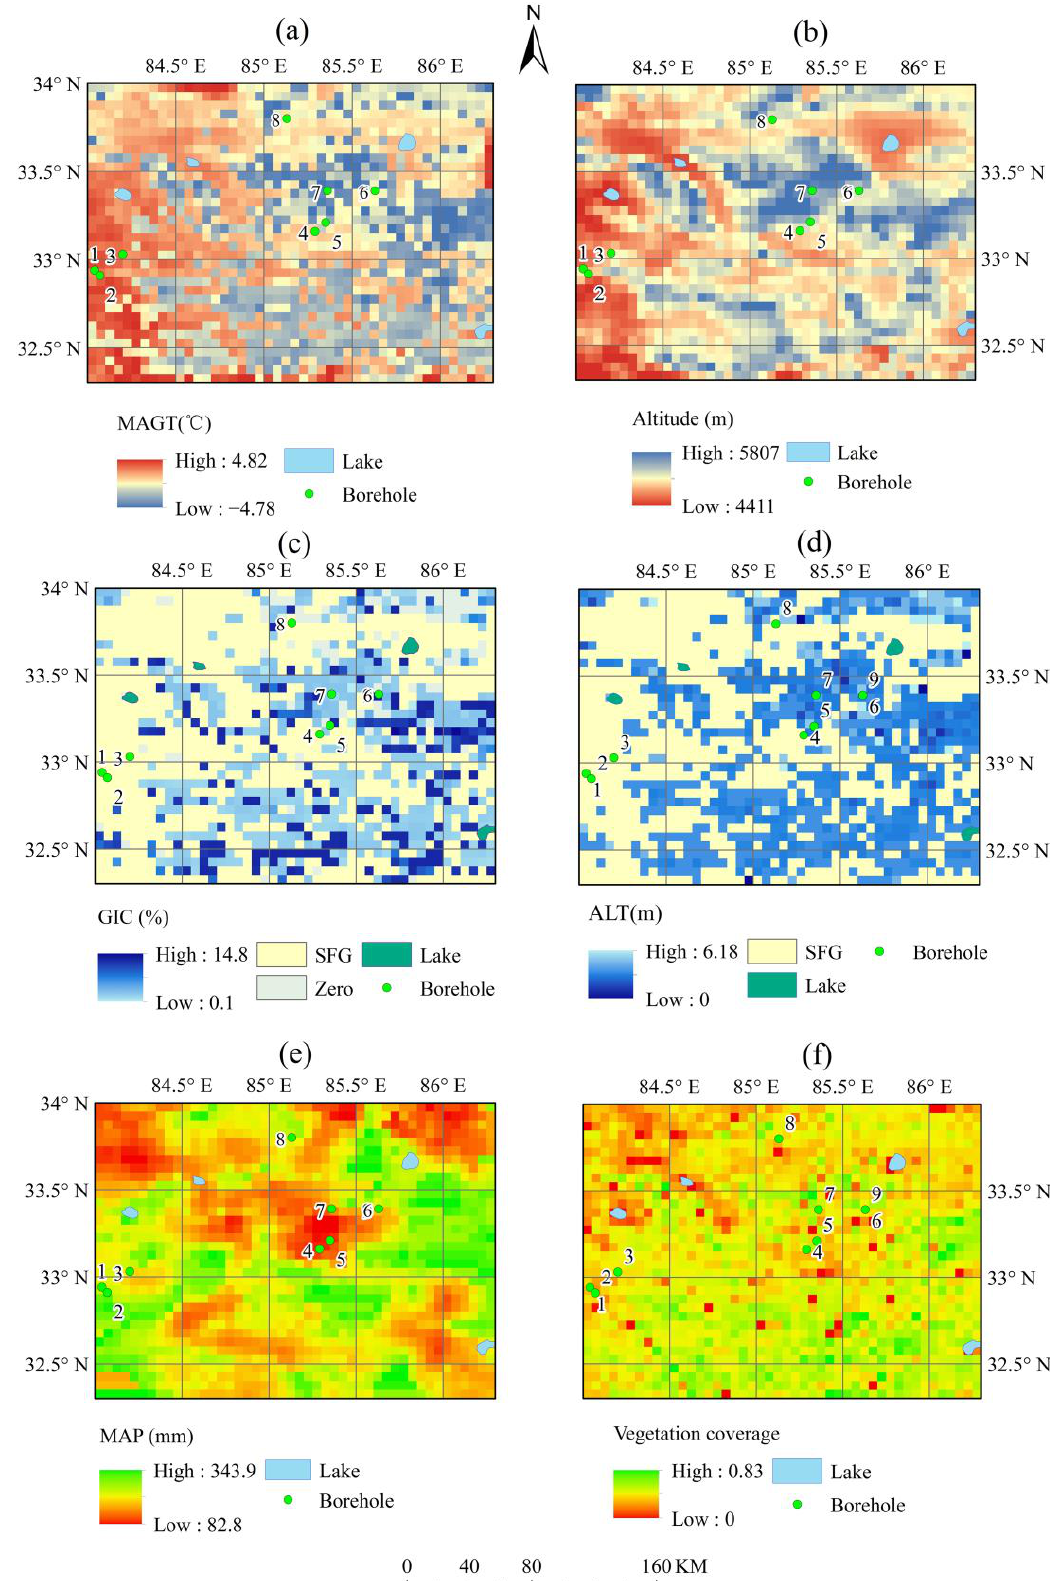
Figure 8. Distribution of ( a ) simulated MAGT; ( b ) altitude; ( c ) simulated ground ice content (GIC); ( d ) simulated Active layer thickness (ALT); ( f ) Mean annual precipitation (MAP); ( e ) vegetation coverage in the Gaize area (Borehole number 1 to 9 correspond to the borehole ID in Table 1).